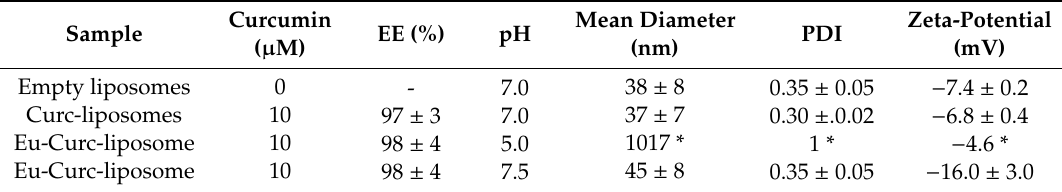
Figure 1. Sketch illustrating the behavior of Eu-curc-liposomes with increasing pH, up to the dissolution of the polymeric coating (A) . Transmission electron microscopy (TEM) micrograph of Eu- curc-liposomes at pH 5.0. Scale bar: 200 nm ( B ). TEM micrograph of Eu-curc-liposomes at pH 7.5. Scale bar 100 nm ( C ).